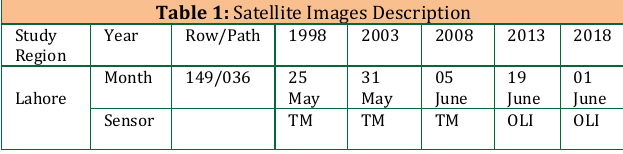
Table 1: Satellite Images Description